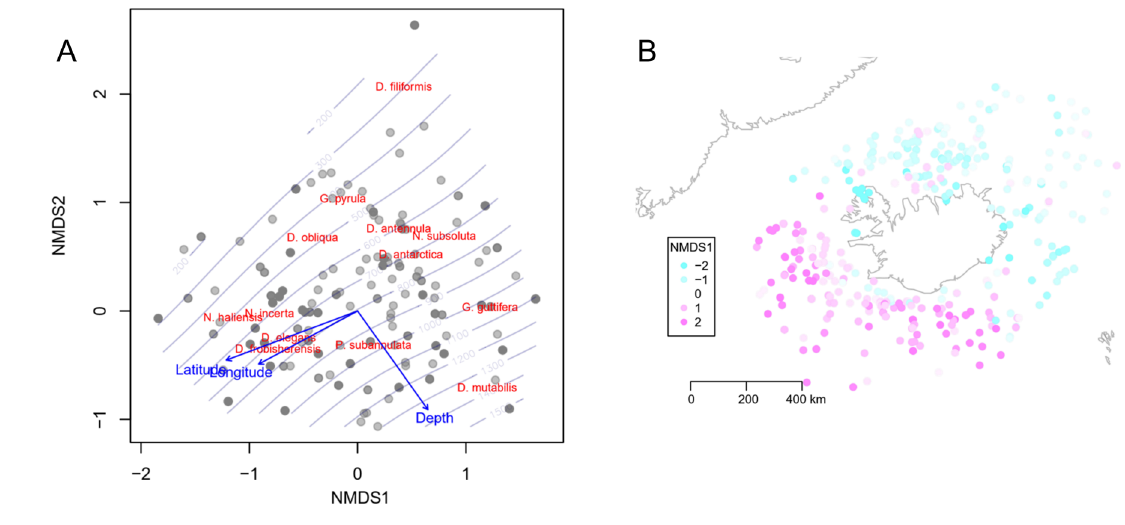
Fig. 22. Results of non-metric multidimensional scaling (NMDS) ordination of community composition based on Bray-Curtis dissimilarities on presence/absence data from BIOICE samples of the RP- epibenthic and detritus sledges. A . Ordination plot showing site scores as grey dots and species positions in red. Level curves for depth (pale blue) are fitted to NMDS scores with a generalized additive model (vegan function ordisurf). Blue vectors represent linear effects of environmental gradients in latitude, longitude, and depth fitted with the vegan function envfit. B . Map of Icelandic waters with sites colour coded by their scores on the first NMDS